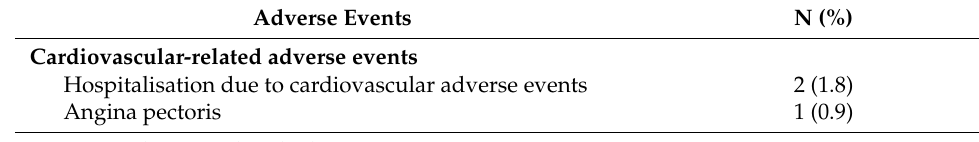
Table 4. Adverse events and withdrawal symptoms after varenicline use (N =